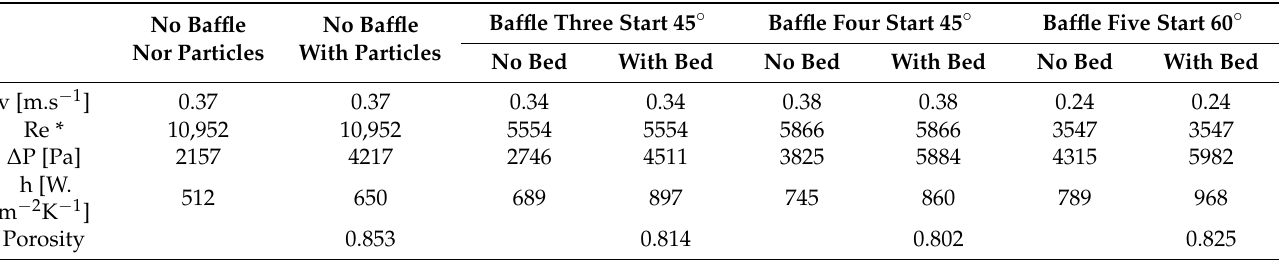
Figure 10. Helical baffle with concentric heater .